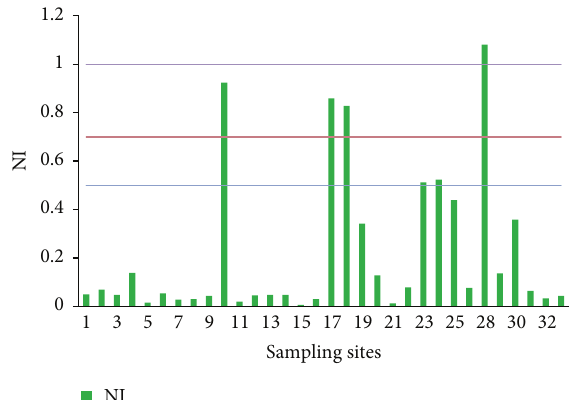
Figure 4: NIs of heavy metals at all groundwater sampling